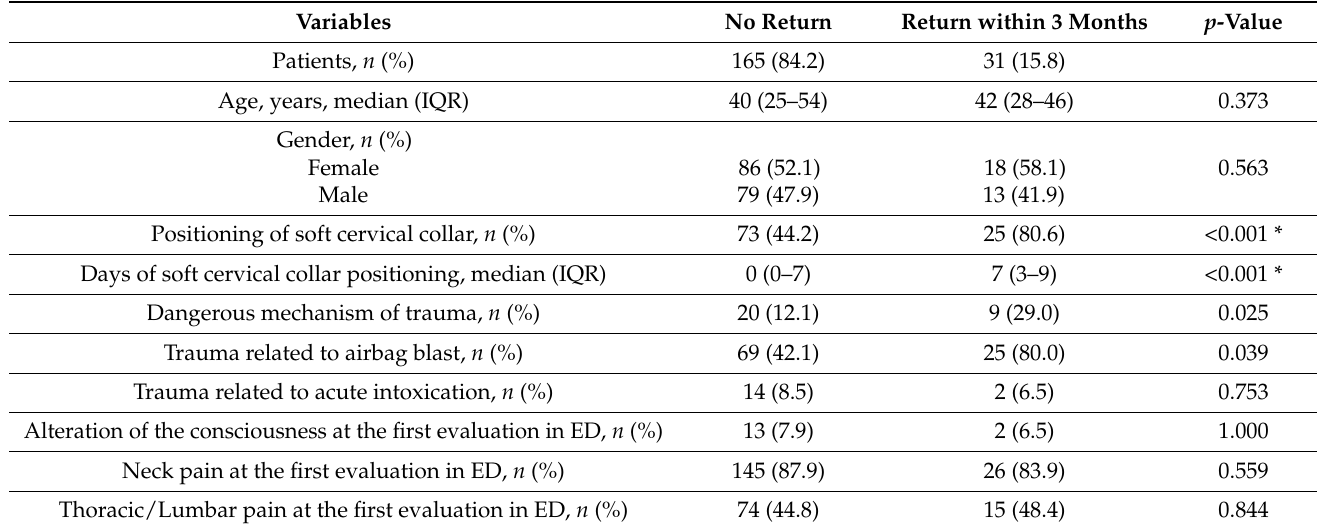
Table 5. Propensity score matching for the return to the emergency